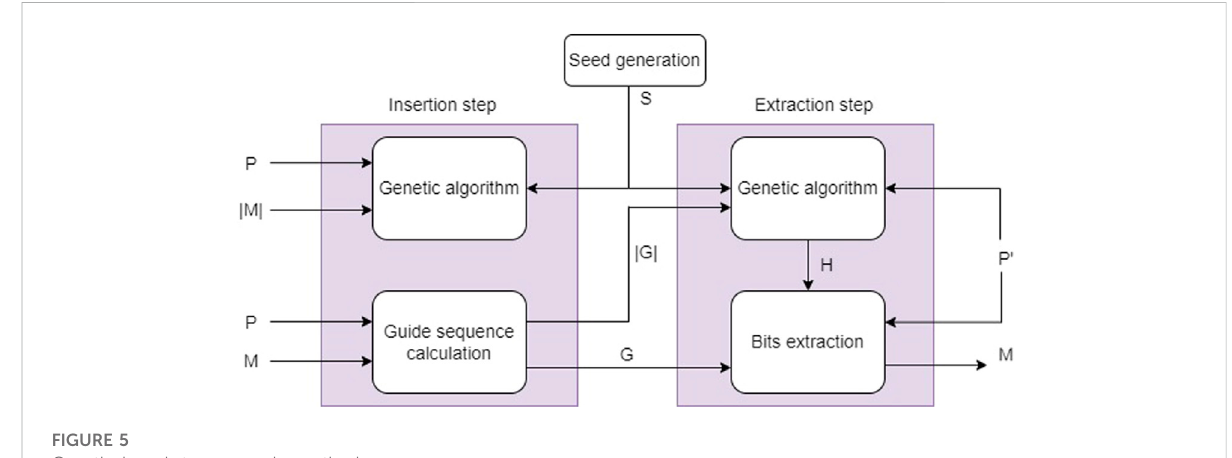
FIGURE 5 Genetic-based steganography